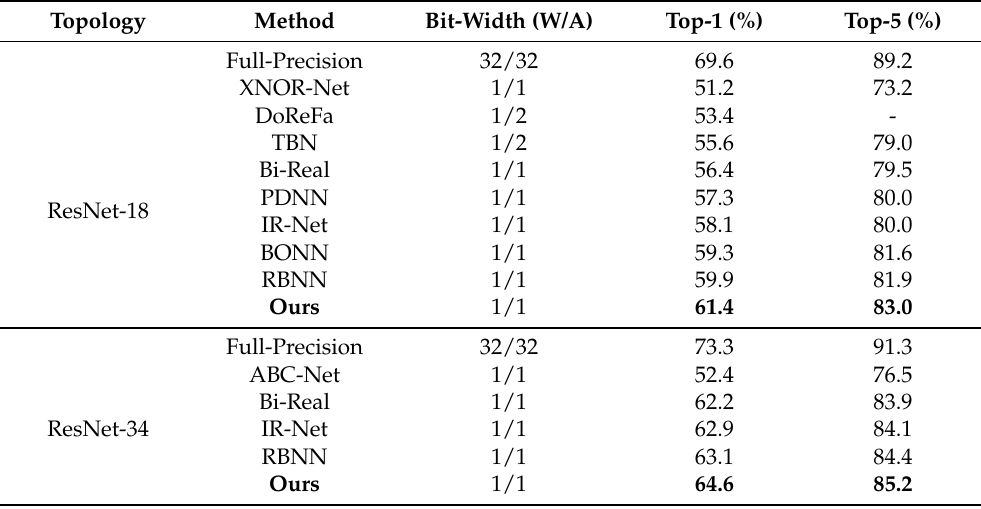
Table 5. Accuracy comparison with the SOTA methods on the ImageNet dataset. We evaluate our proposed IE-Net based on ResNet-18 and ResNet-34. The proposed networks are highlighted in bold. Topology